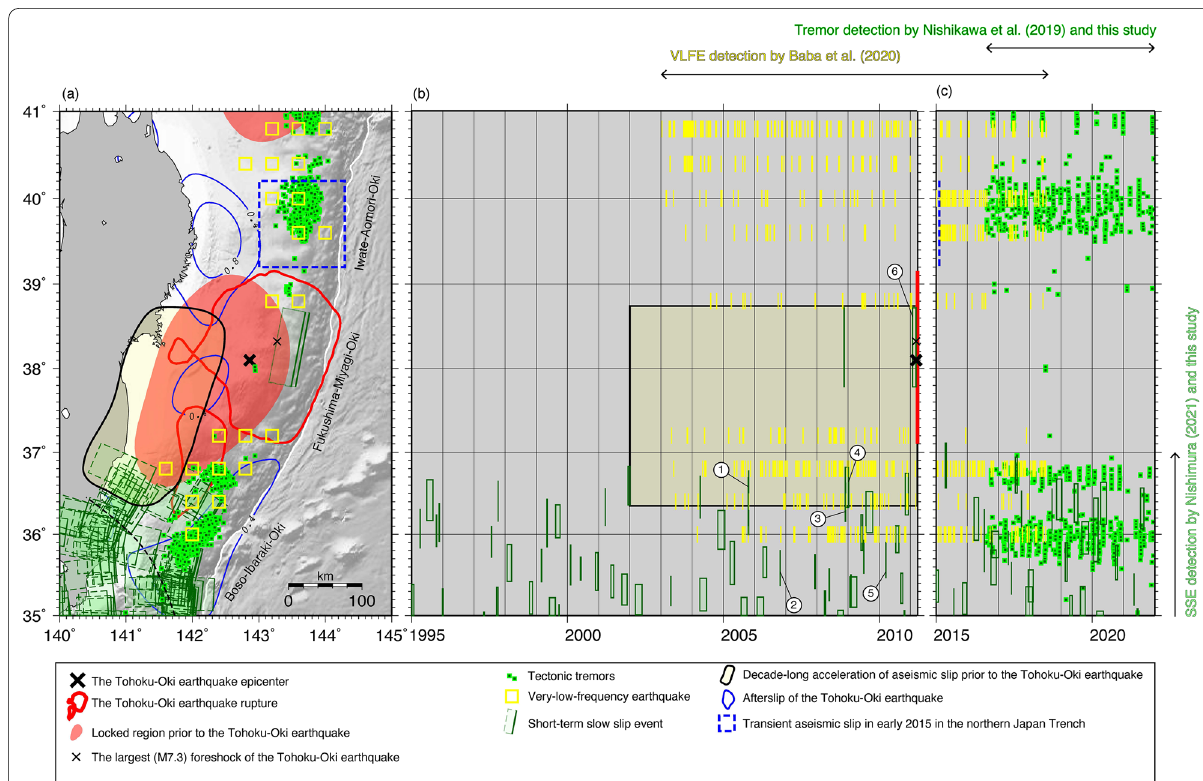
Fig. 6 Slow earthquake activity in the Japan Trench before and after the 2011 Tohoku-Oki earthquake. a Epicenters of the slow earthquakes. b Spatiotemporal distribution of the slow earthquakes before the March 11, 2011, Tohoku-Oki earthquake. Potential ETSs before the Tohoku-Oki earthquake are numbered 1–6. c Spatiotemporal distribution of the slow earthquakes from January 2015 to December 2021. For an explanation of the symbols, refer to the legend in the figure. The epicenter of the Tohoku-Oki earthquake and its largest foreshock are from the JMA catalog. The coseismic slip (10 m or larger) and afterslip (April 23, 2011 to December 10, 2011) of the Tohoku-Oki earthquake are based on Iinuma et al. (2012) and Iinuma et al. (2016), respectively. The afterslip distribution is shown at 0.4 m intervals. The interplate locked region prior to the Tohoku-Oki earthquake is based on the slip deficit distribution estimated by Suwa et al. (2006) (larger than 6 cm/year, i.e., approximately 70% plate coupling). Tectonic tremors and VLFEs are from Nishikawa et al. (2019) and Baba et al. (2020), respectively. In the figure, we showed tectonic tremors with a duration of more than 80 s. Short-term SSEs are from Ito et al. (2013) and Nishimura (2021). The decade-long acceleration of aseismic slip prior to the Tohoku-Oki earthquake (10 cm or larger) is from Yokota and Koketsu (2015). The transient aseismic slip in early 2015 in the northern Japan Trench is based on Honsho et al.